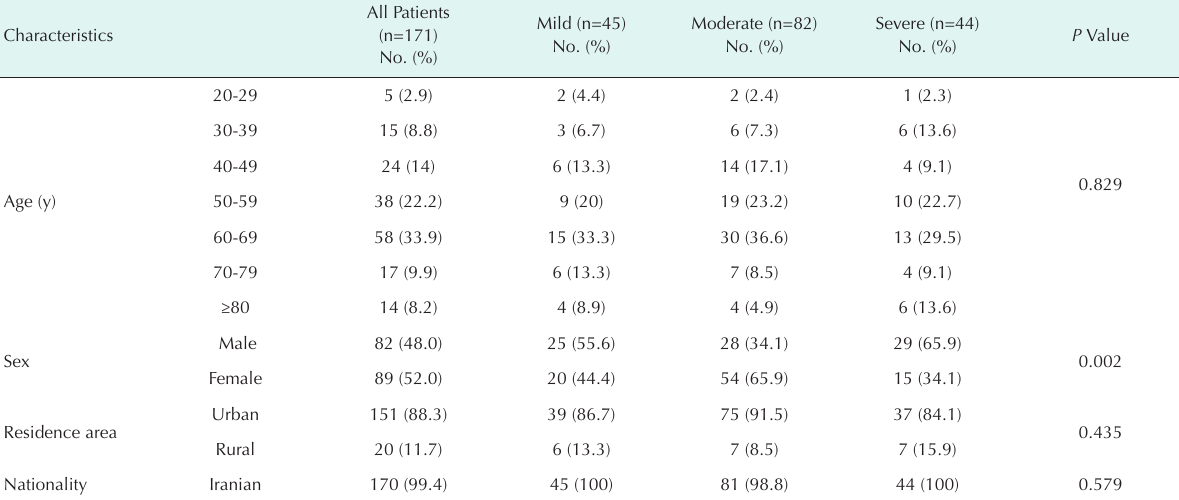
Table 1. Demographics and Social Characteristics of Diabetic Patients With COVID-19 in Different Groups of Severity Characteristics